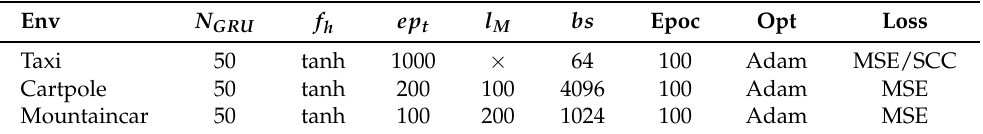
Table A2. Parameter for the training of the RNNs for the actual and counterfactual prediction in different environments: N GRU is the number of GRU, f h is the activation function used, ep t is the number of episodes for the dataset creation, l M is the maximum length of the episodes, bs is the batch size, epoc is the number of epochs, opt is the optimizer used and loss is the loss function (where MSE is Mean Square Error and SCC is Sparse Categorical Crossentropy).